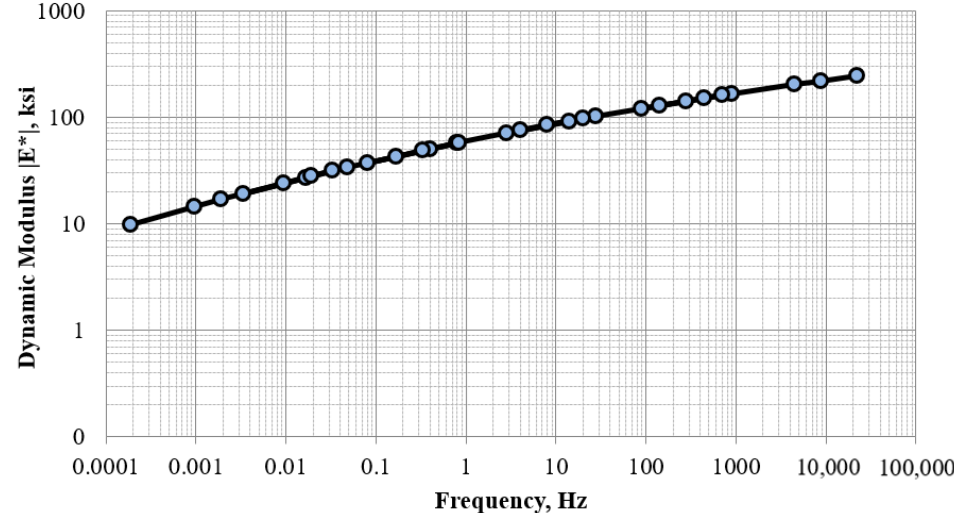
Figure 10. Master curve for RAP2 milling materials at 22% AV and 20 °C reference temperature.